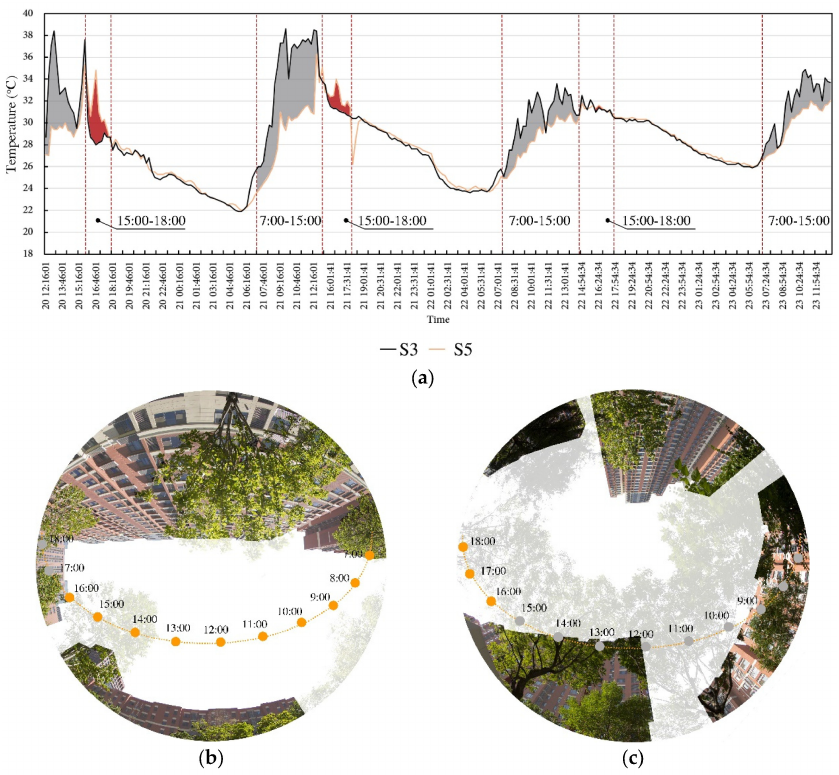
Figure 14. Ta changes ( a ) at 20–23 August and fisheye photos ( b , c ) of S3, S5 in Shuangqing